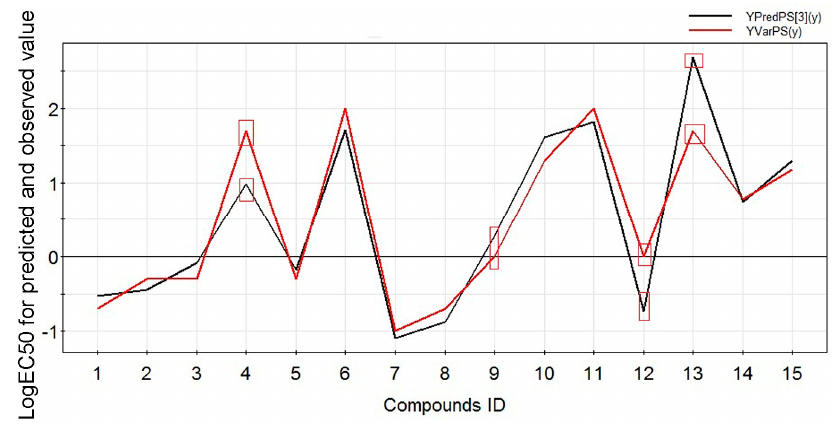
Figure 4. The comparison between the predicted and observed values (compound ID 4 , 9 , 12 , 13 as the test set, and others as the training set). Table 1. Predicted and experimental values of four diterpenoid alkaloids.